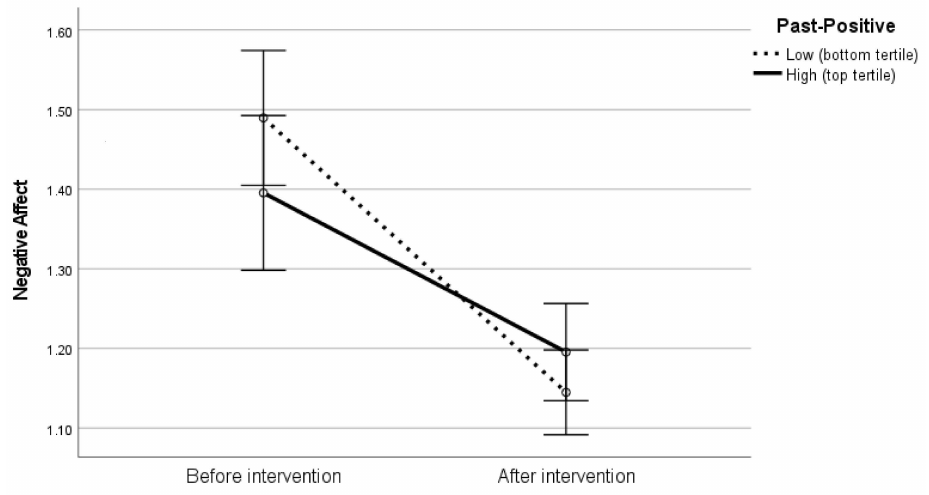
Figure 1. Interaction between gratitude intervention and Past-Positive perspective in predicting negative